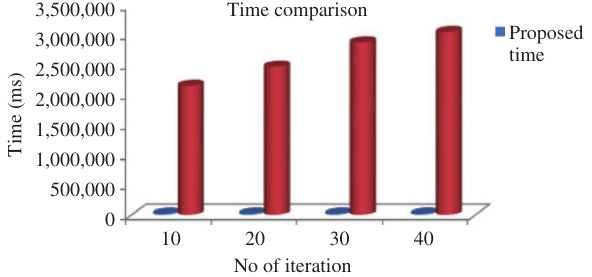
Figure 11: Comparative Analysis of Execution Time.